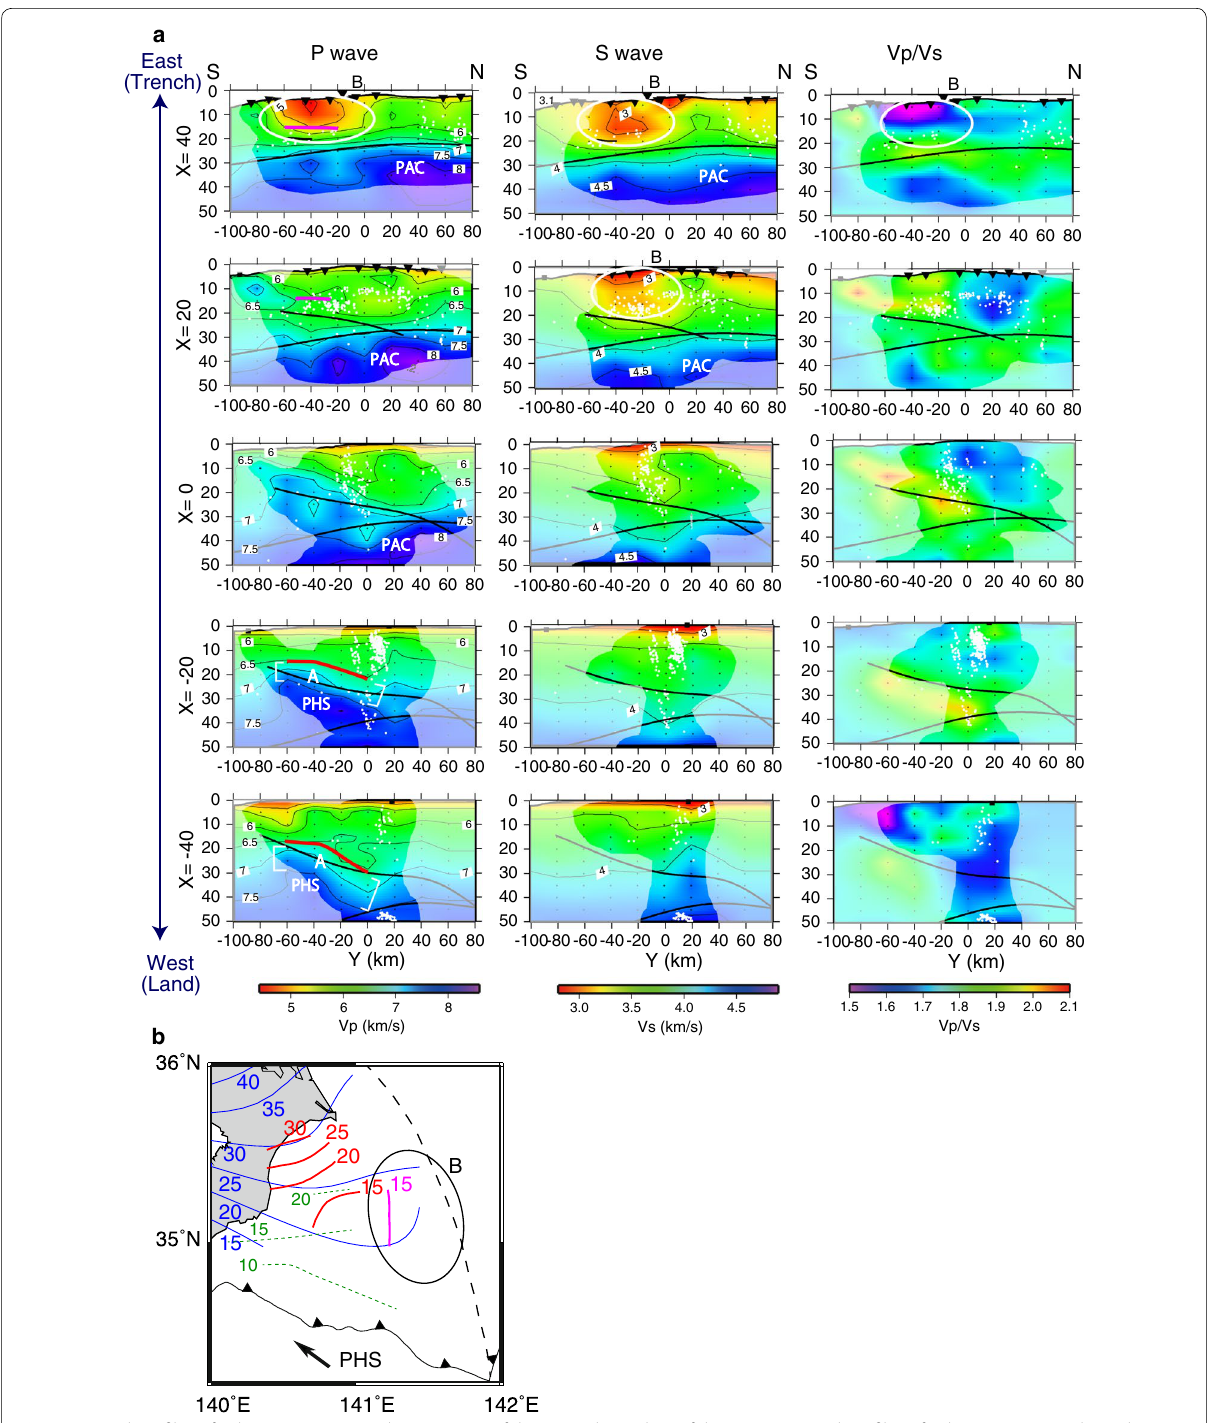
Fig. 5 Vertical profiles of velocity structure and geometries of the upper boundary of the PHS. a Vertical profiles of velocity structure along the Y axis shown in Fig. 2c. b Geometries of the upper boundary of the PHS. Red and magenta lines show the depths of the upper boundary of the PHS based on the tomographic image and results by Ito et al. (2017), respectively. Blue and green dotted contours show depths of the upper boundaries of the PHS estimated by Uchida et al. (2010) and compiled by Kono et al. (2017). The location of the low-velocity anomaly in the NA plate is indi- cated by the black circle labeled